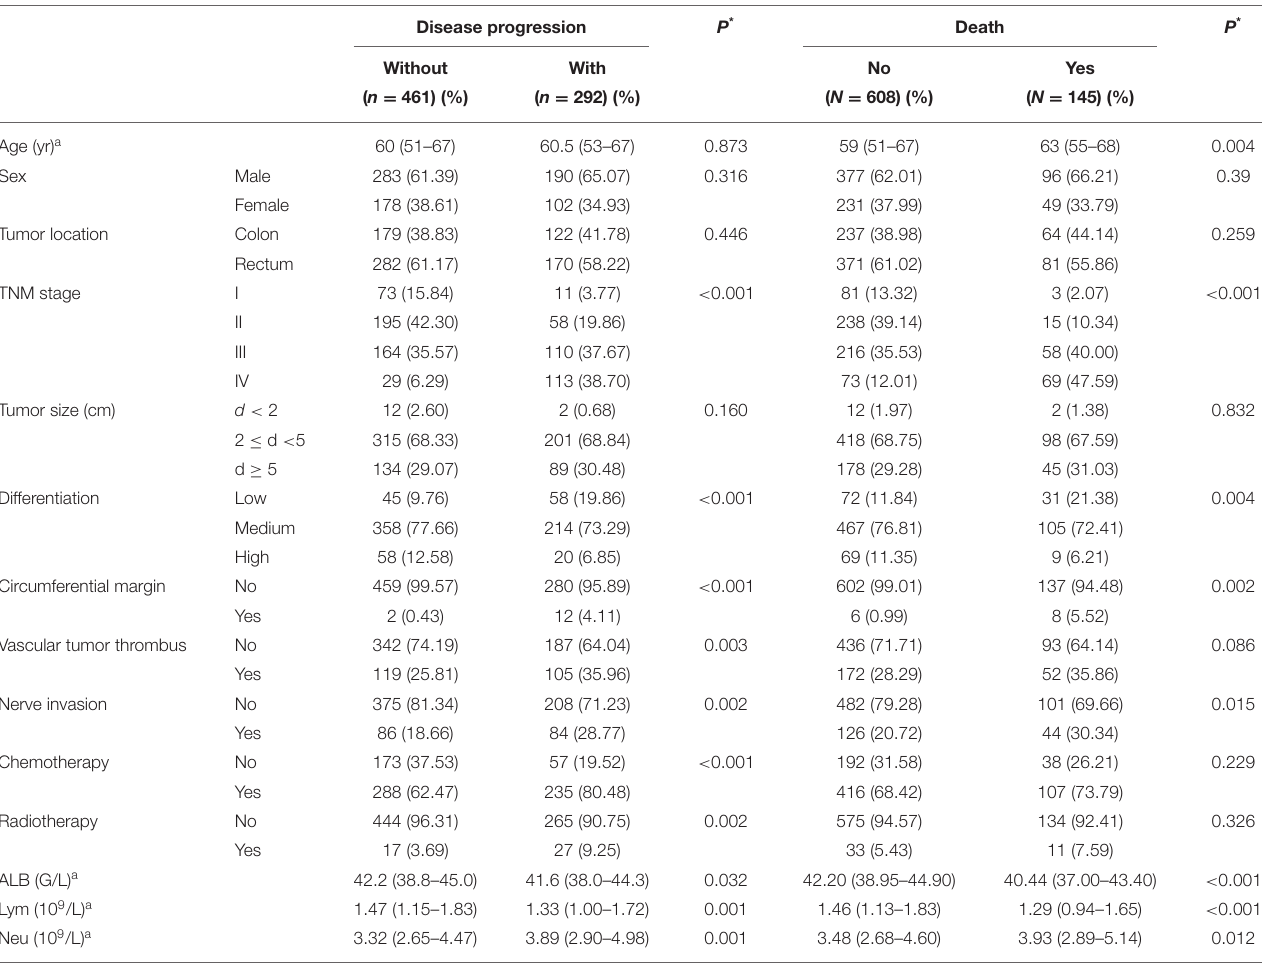
TABLE 1 | Baseline clinicopathological characteristics of colorectal cancer